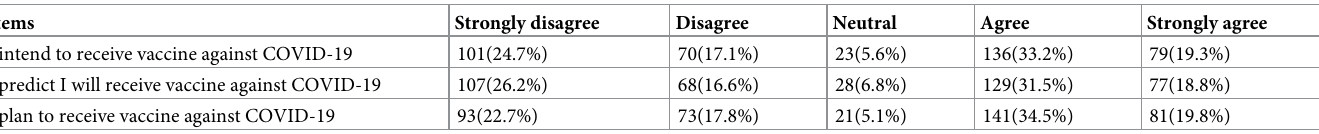
Table 2. Intention to receive vaccine against COVID-19 among health professionals at selected hospitals in south-west, Ethiopia, 2021.